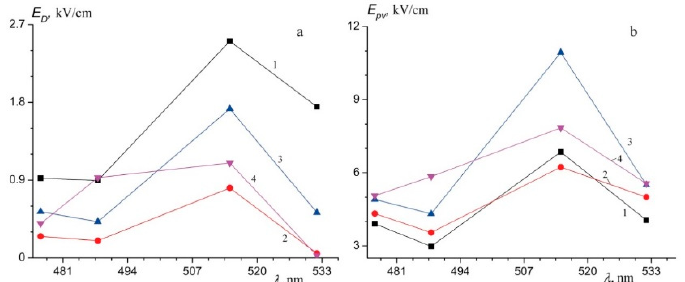
Figure 11. Dependence of E D ( а ) and E pv ( b ) on wavelength for the crystals SLN (1), CLN (2) and LiNbO 3 :B (0.55 (3), 0.83 (4) mol%). The figure is reproduced with the permission of Pleiades Pub- lishing from the paper N. V. Sidorov et. al., Techn. Phys. 2020 V. 65 P. 627–634, DOI: https://doi.org/10.1134/S1063784220040192 (accessed on 26 March 2021).